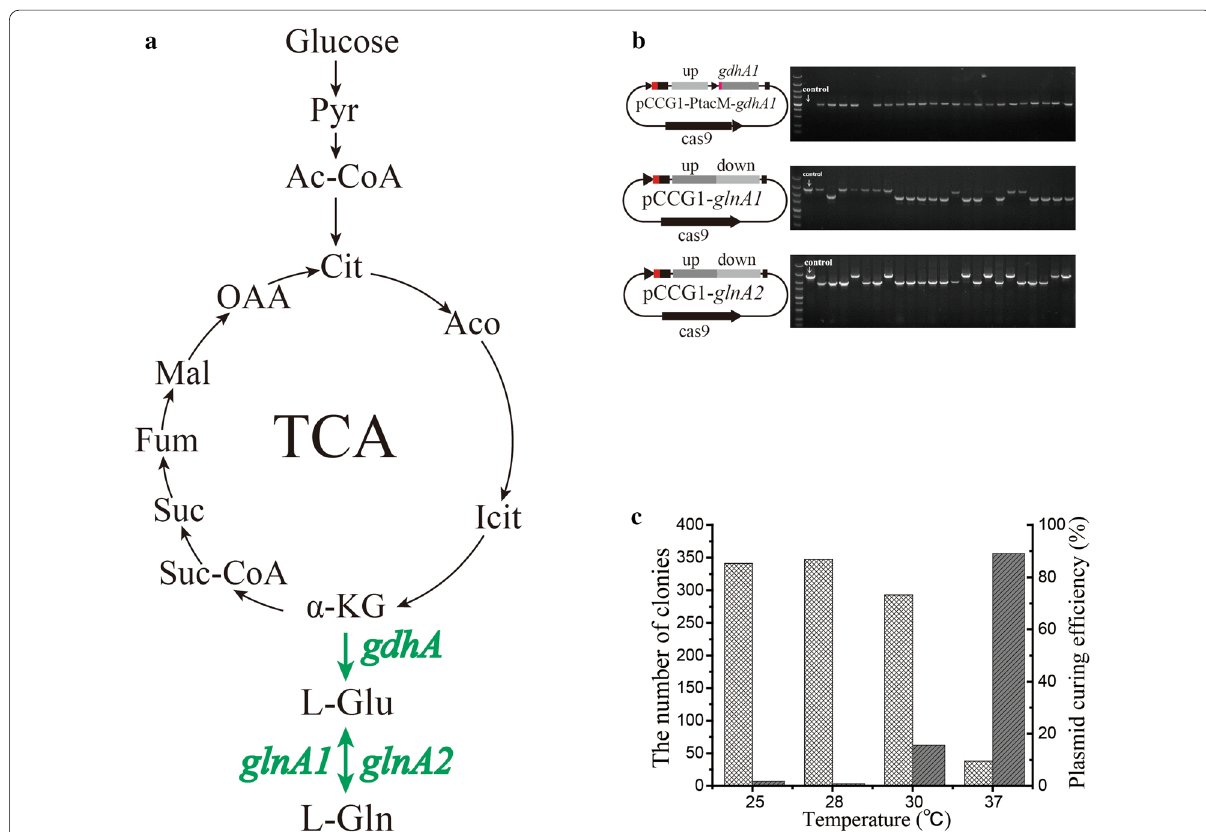
Fig. 2 l -Glu and l -Gln biosynthetic pathway and the results of gene editing. a l -Glu and l -Gln biosynthetic pathway. Pyr: pyruvate; Ac-CoA: acetyl-CoA; Cit: Citrate; Aco: cis-aconitate; Icit: isocitate; α-KG: alpha-ketoglutaramate; Suc-CoA: succinyl-CoA; Suc: succinate; Fum: fumarate; Mal: malate; OAA: oxaloacetate. b The first lane is DNA marker and the second lane is the control before editing, the upstream primer of gdhA1 was designed in promoter PtacM, there is no PCR product in negative cells. c The plasmid stability at different temperature. The cells harboring plasmid were cultured at 25 °C, 28 °C, 30 °C and 37 °C respectively, the total number of colonies were counted by cfu per